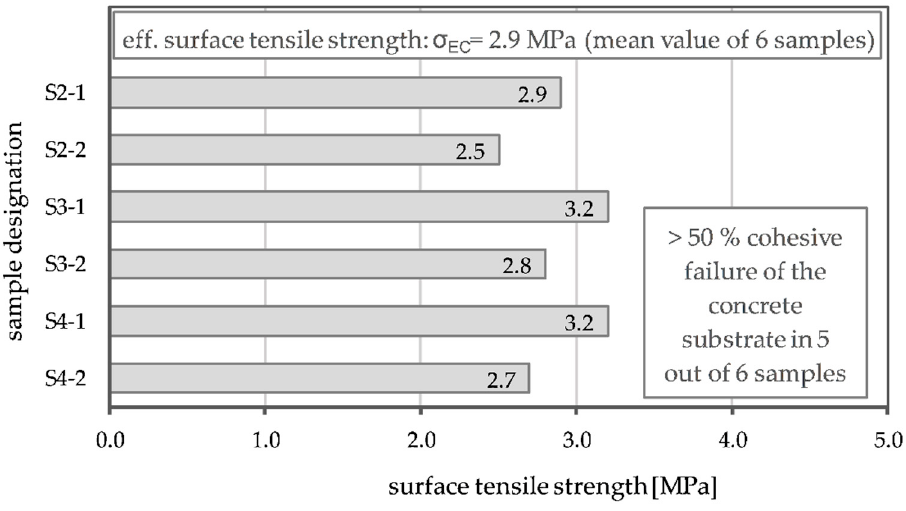
Figure 8. Surface tensile strength (MPa) of the transmission tower pillar (measured on three sides (S); two measuring points one each side) presented as single values.